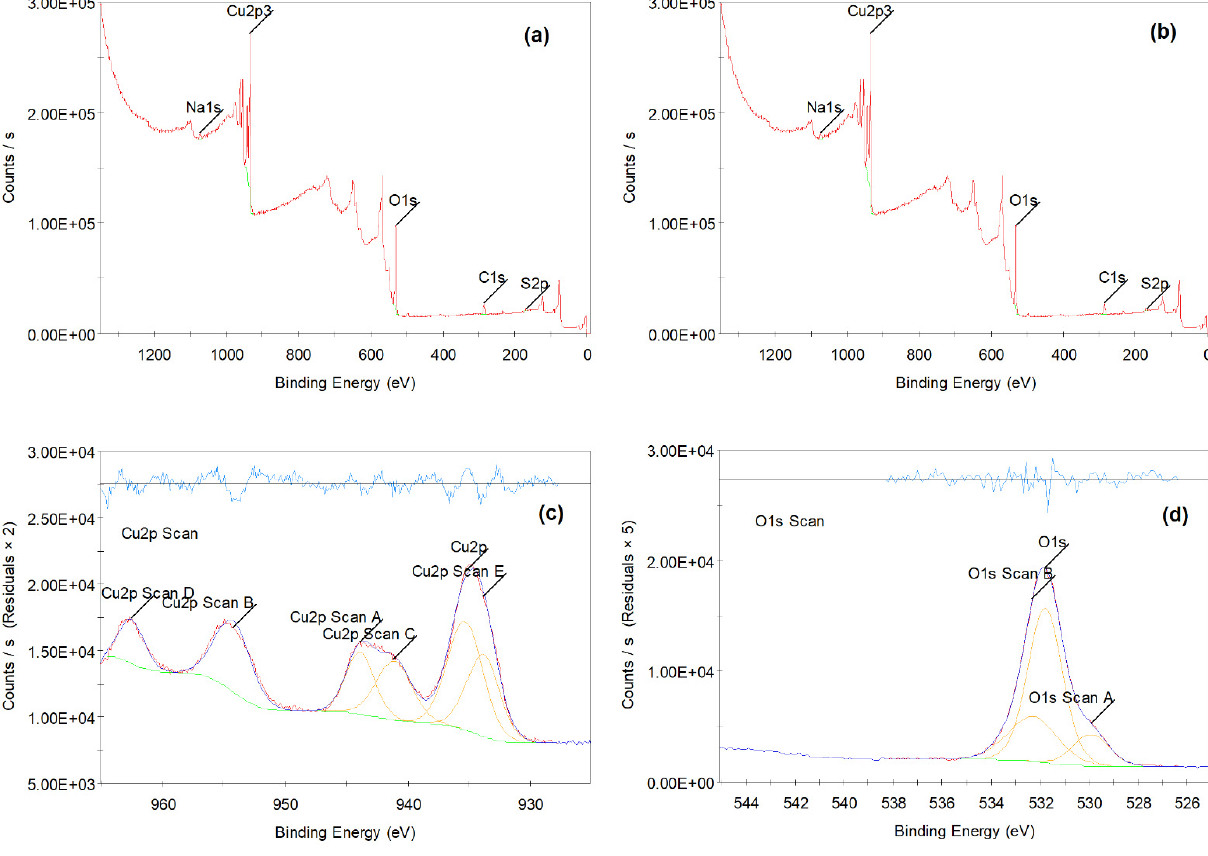
Figure 4. Survey or wide energy range X-ray photoelectron spectroscopy (XPS) spectra of CuO NPs ( a ), G CuO NPs ( b ) and high resolution (Core level) or narrow energy range spectra of Cu 2p ( c ) and O 1s ( d ), from the G CuO NPs.